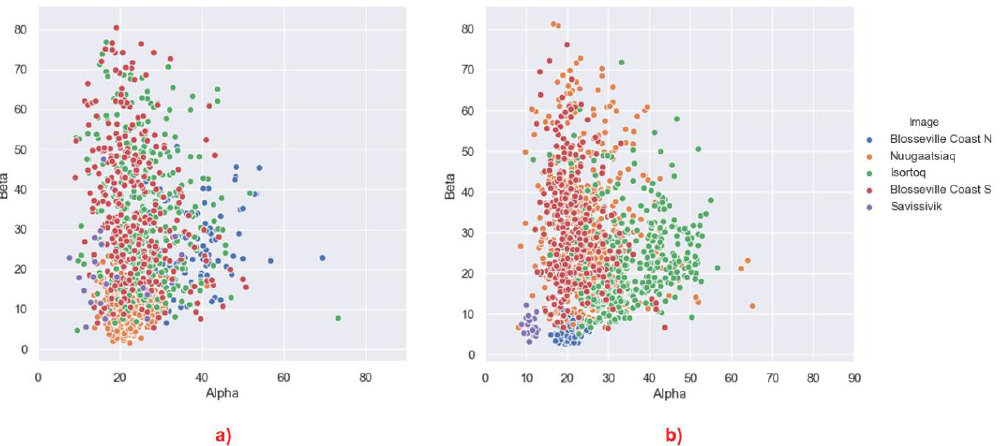
Figure 15. ( a ) Iceberg alpha vs. beta plot 5 × 5 window, ( b ) 11 × 11 window. Colour legend indicates image. Dots indicate icebergs.